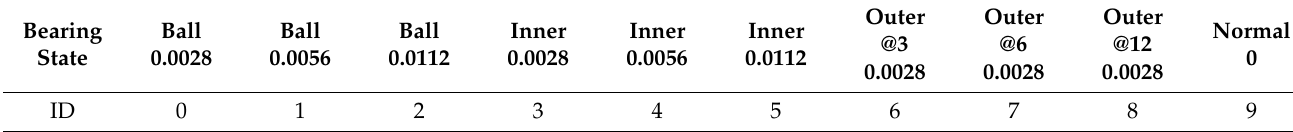
Table 6. The numerical ID of the rolling bearing